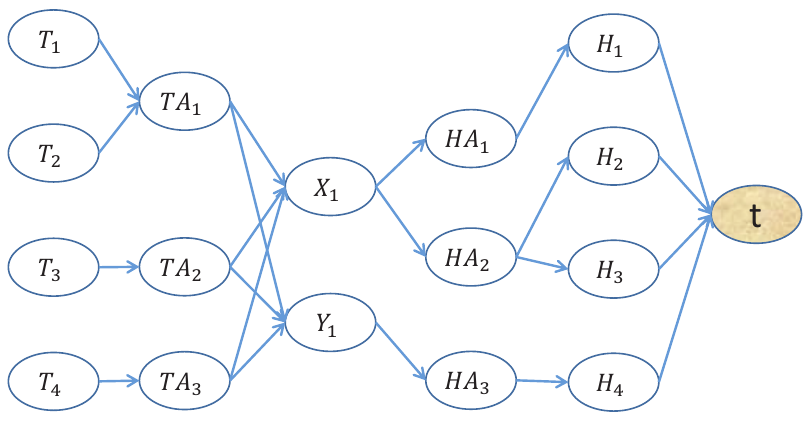
Figure 2. Network structure in